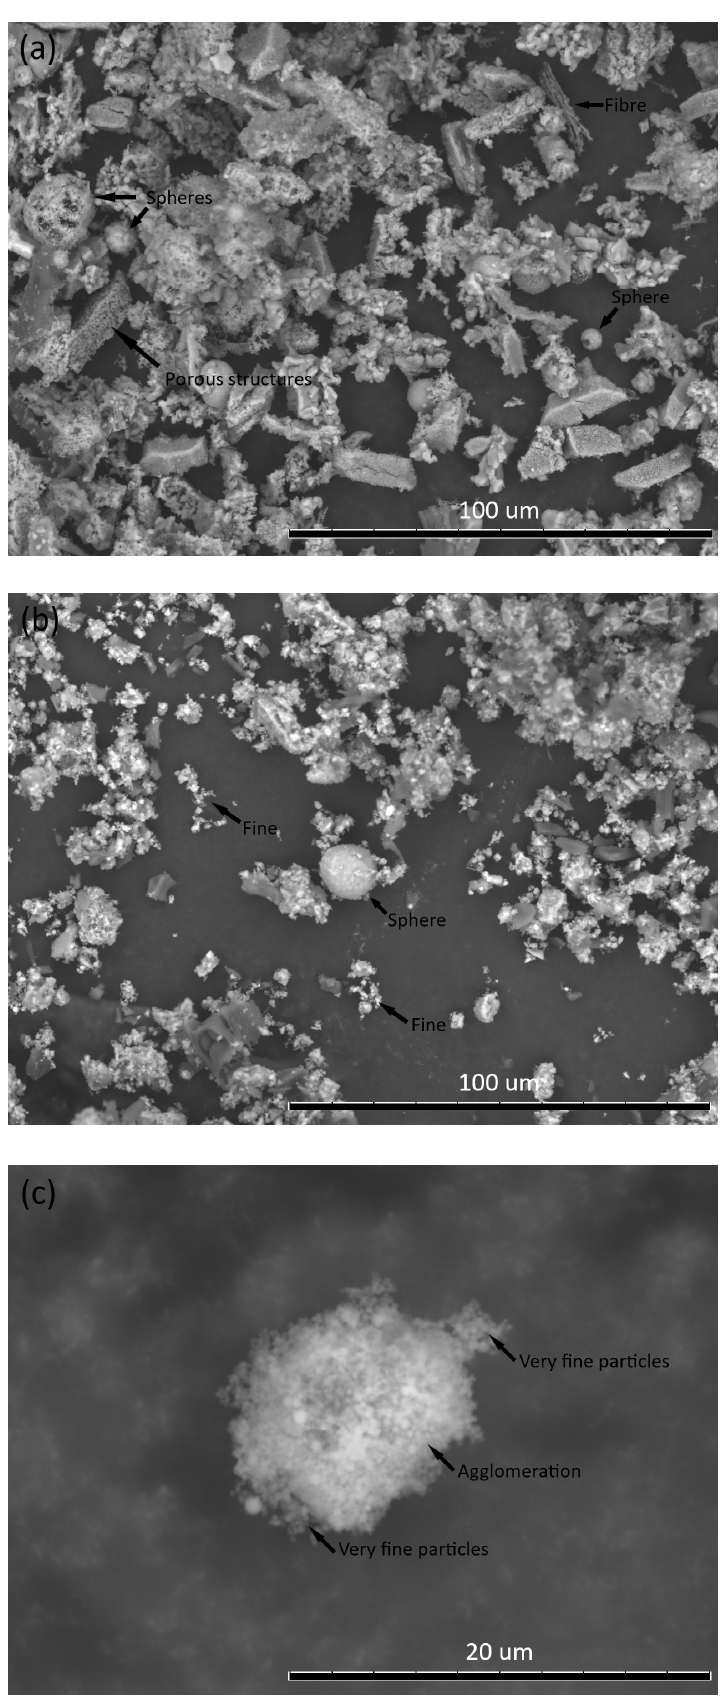
Figure 4. Images obtained by SEM ( a ) EBA as received, ( b ) ground EBA, and ( c ) SF.